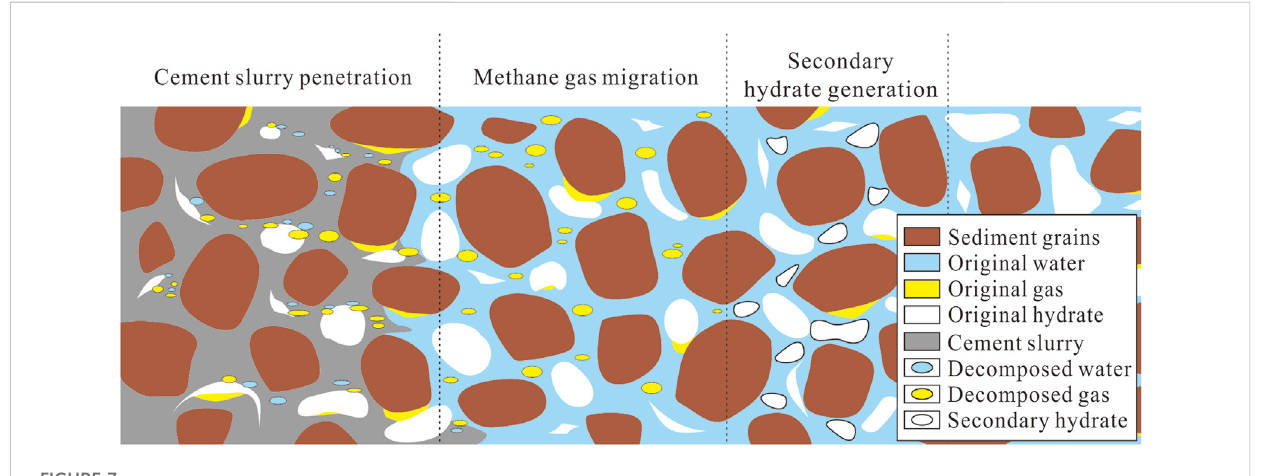
FIGURE 7 Schematic diagram of Secondary hydrate